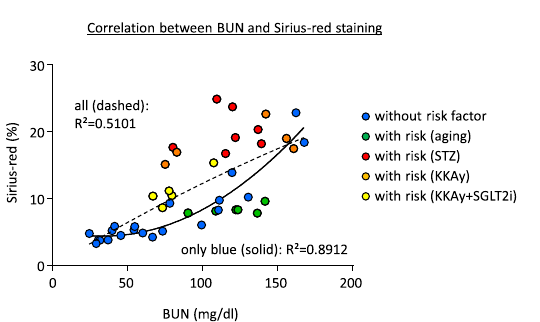
Figure 6. Correlation between the BUN at day 8 after I/R and Sirius red staining at week 8 after I/R. The data from each mouse with or without risk factors was plotted